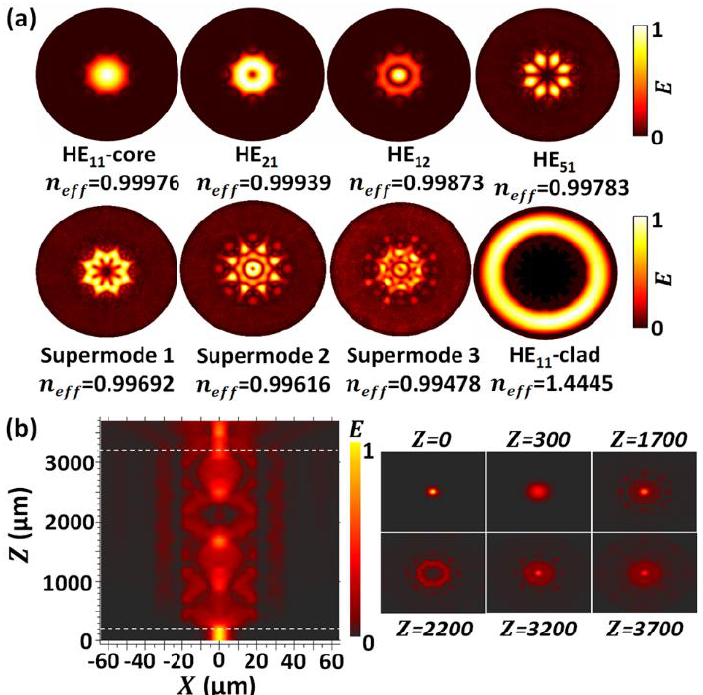
Figure 2. ( a ) Examples of different mode profiles (normalized) within the NCHCF, and their corresponding effective refractive indices, simulated by an finite-element method (FEM).; ( b ) Energy distributions in the XZ plane along the SMF-NCHCF-SMF length (lengths of the input and output SMF, and NCHCF are 200 µ m, 500 µ m and 3000 µ m, respectively) and the mode profile evolution at the cross-section at different fiber structure lengths, simulated by a beam propagation method (BPM).